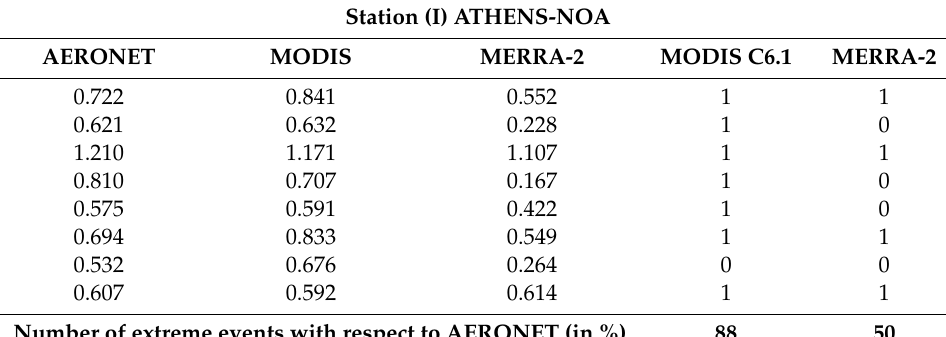
Table A1. Daily mean AOD for days classified as extreme events according to AERONET values equal or above the threshold 0.5, with respect to the three ground-based stations. The numbers 0 and 1 for MODIS and MERRA-2 indicate if detection of extreme events has been done or not,